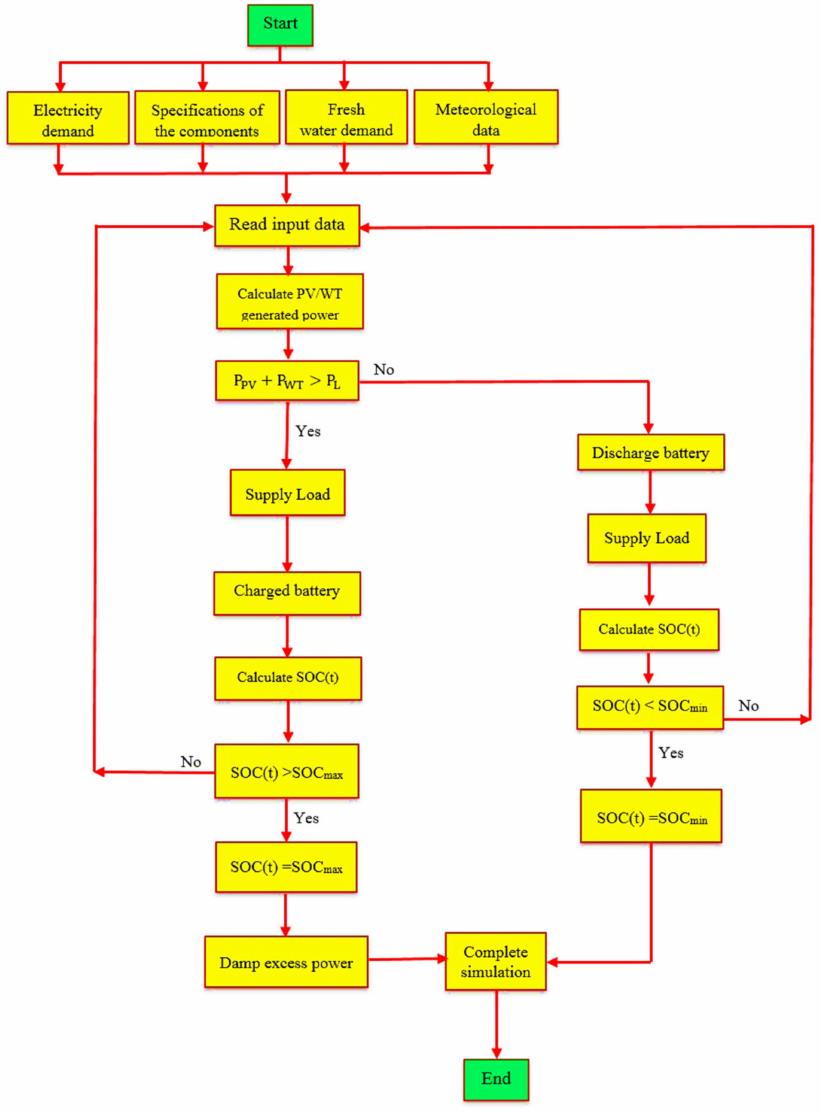
Figure 2. Schematic of a hybrid renewable energy microgrid’s power control and management system from Kiehbadroudinezhad et al. [6]. With permission from John Wiley & Sons Ltd. Copyright © 2020; License Number: